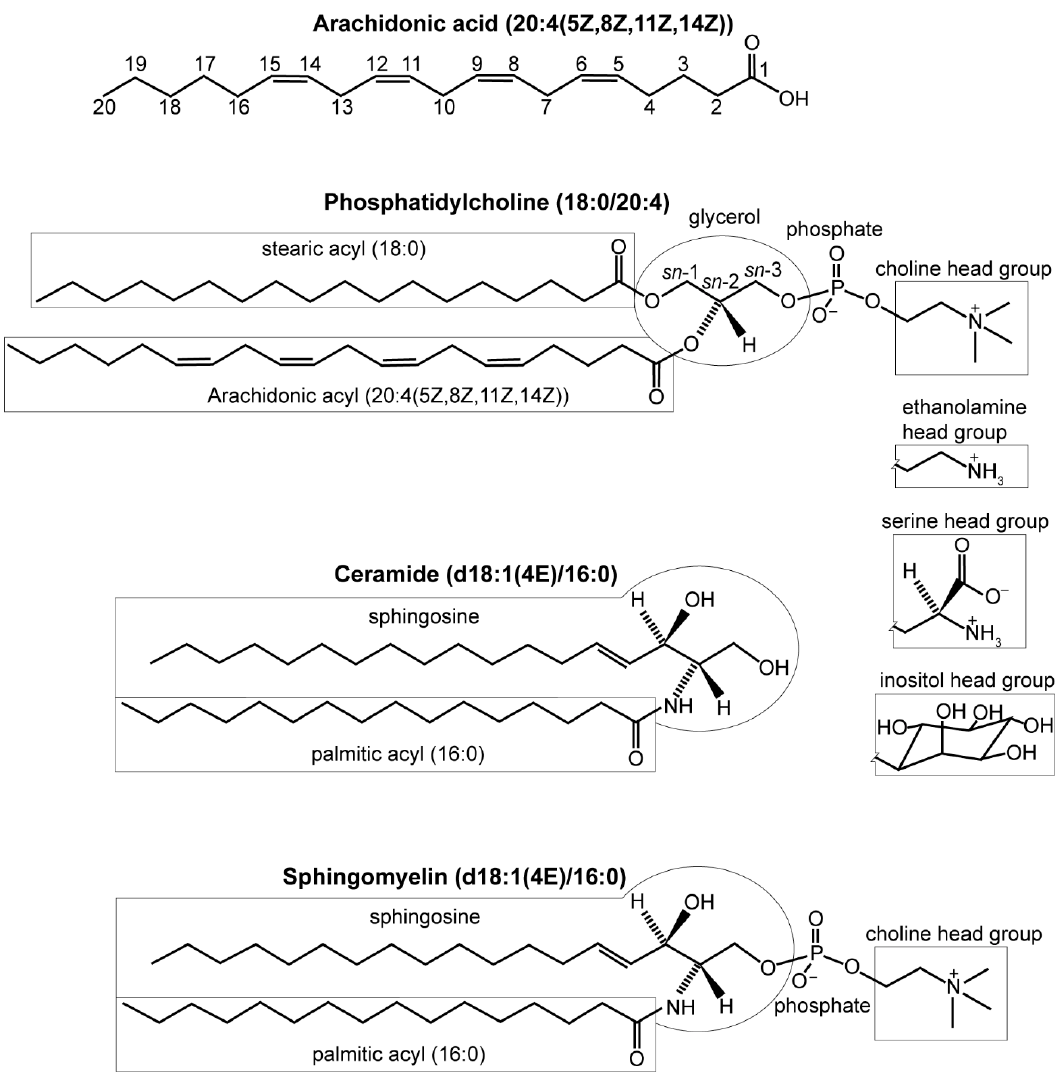
Figure 2. Lipid structures. LIPID MAPS naming conventions indicate “carbon atoms”: “double bonds” (location and conformation of double bonds) [80]. Phosphatidylcholine (PC) is composed of two lipid tails esterified to glycerol 3-phosphate with a choline head group. Glycerol’s stereospecific carbons are numbered sn -1, sn -2, and sn -3 [81]. Phosphatidylethanolamine (PE), phosphatidylserine (PS), and phosphatidylinositol (PI) have the same structure, but with alternative head groups. Ceramide (Cer) contains a sphingosine backbone, and a fatty acyl group. Sphingomyelin is Cer with a phosphocholine or phosphoethanolamine head group. The “d” in the name indicates that these have 1,3-dihydroxy sphingosine backbones.